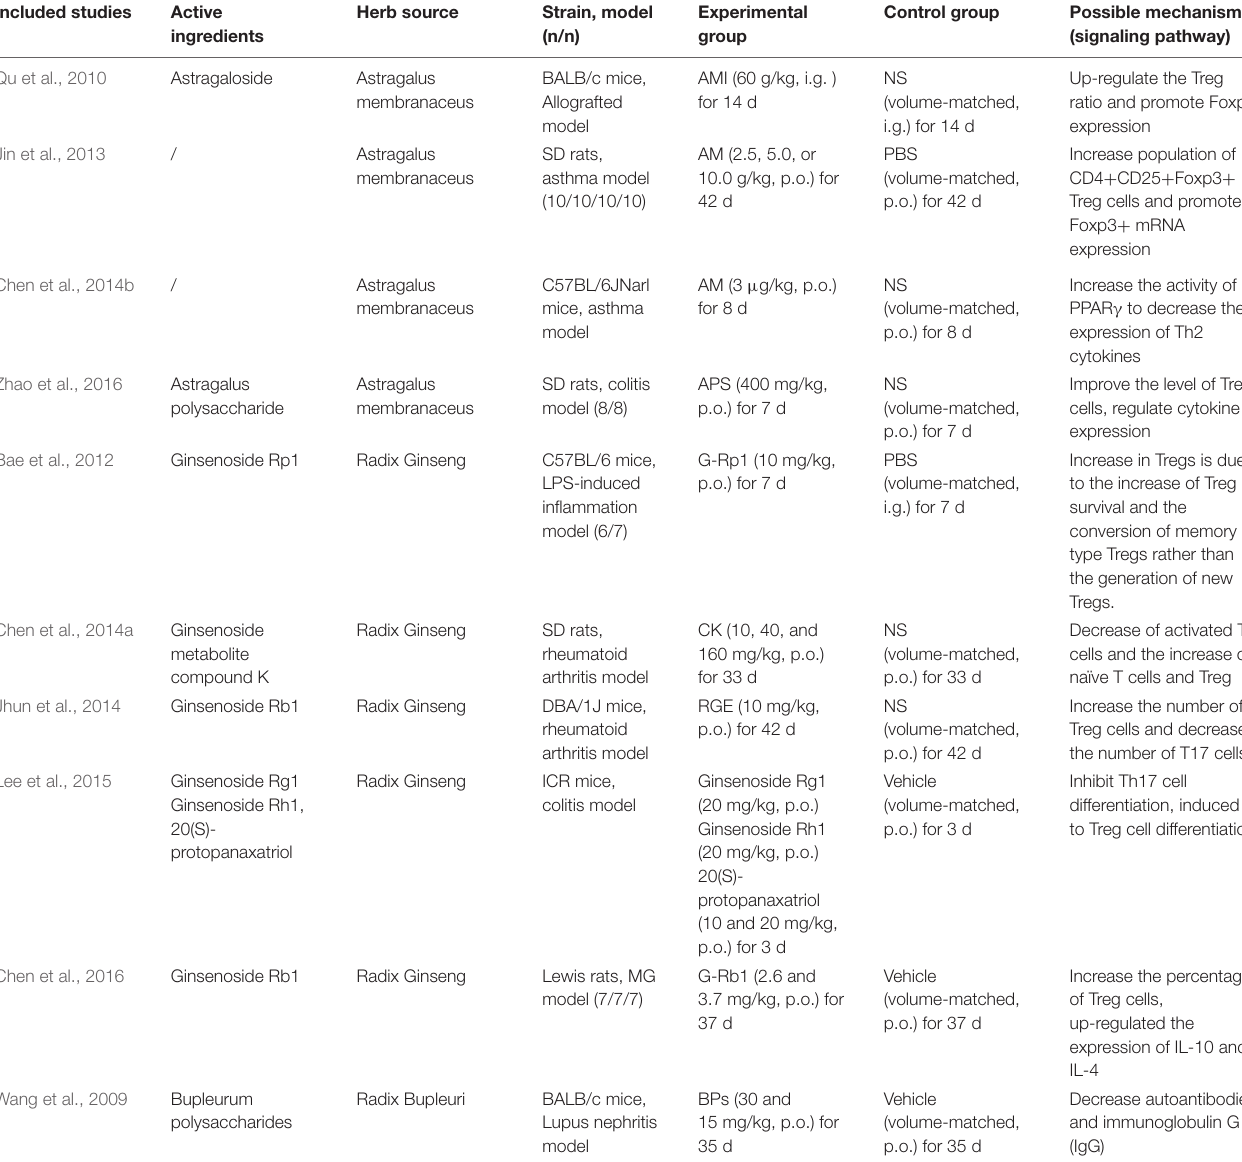
TABLE 5 | Characteristics of mechanism